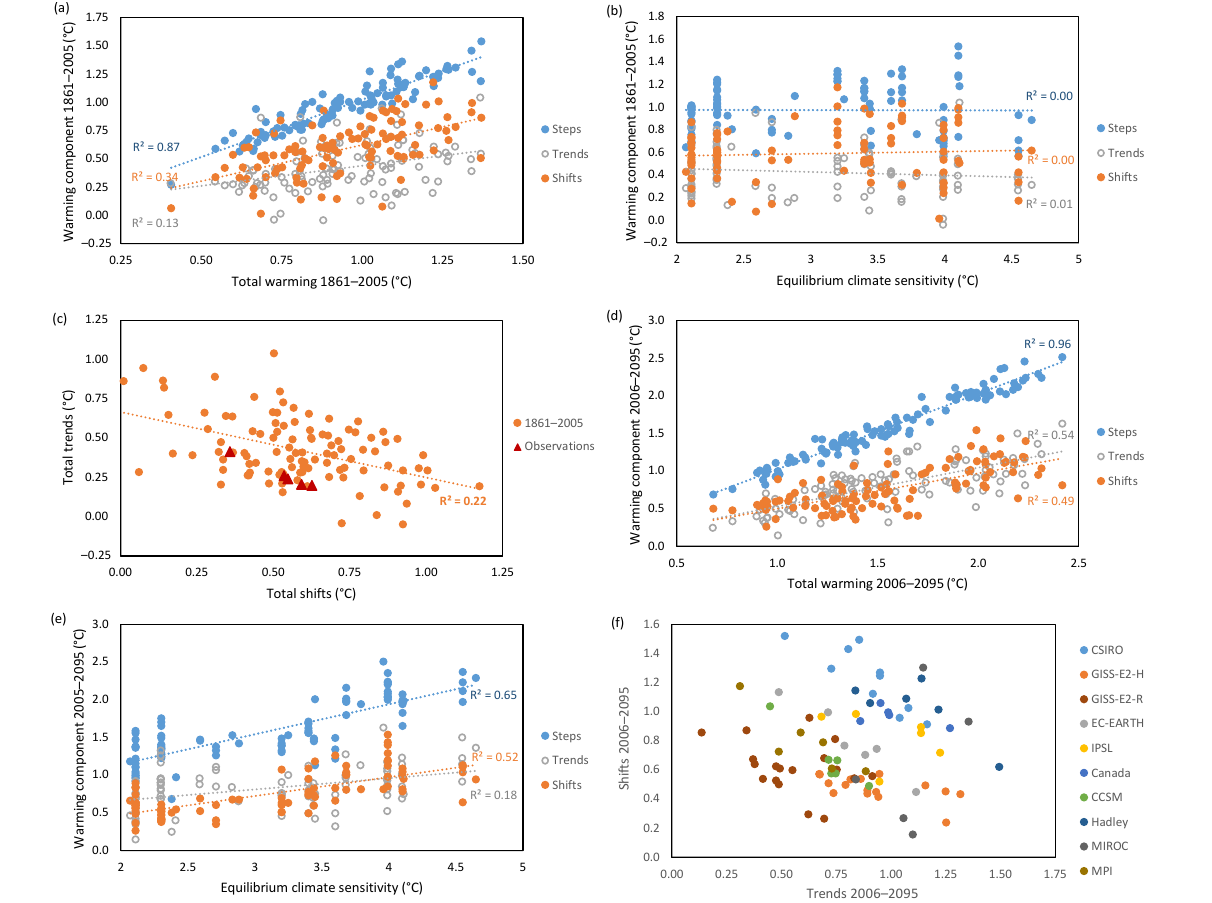
Figure 8. Multi-model ensemble (RCP4.5, 107 members) characteristics of hindcast (1861–2005) and projection (2006–2095) peri- ods. (a) Relationship between total warming and steps, trends and shifts (1861–2005); (b) relationship between ECS and steps, trends and shifts (1861–2005); (c) total shifts and total trends for 1961–2005 with observed points from five warming records; (d) relationship between total warming and steps, trends and shifts (2006–2095); (e) relationship between ECS and steps, trends and shifts (2006–2095); (f) total shifts and total trends for 2005–2095 from individual climate